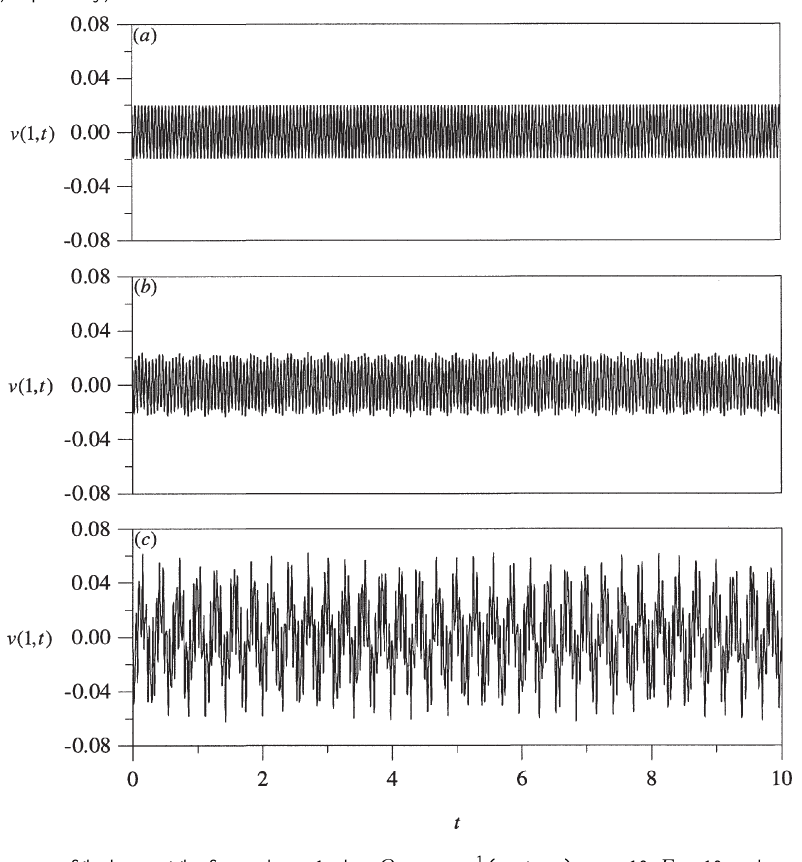
Fig. 3. Steady-state response of the beam at the free end s = 1 when (cid:10) (cid:25) ! 4 (cid:25) 1 (b) (cid:27) 2 = (cid:0) 11, (c) (cid:27) 2 = (cid:0)